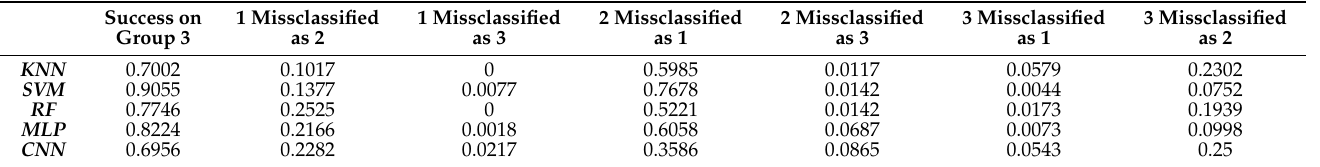
Table 3. Group 3 classification results and results of misclassification between